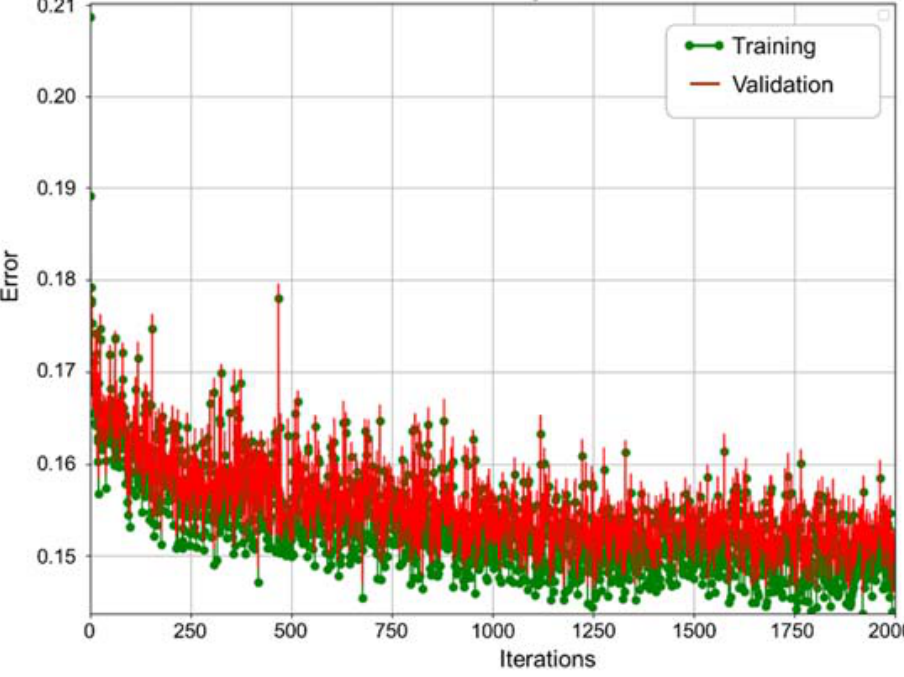
Figure 5. Neural network learning curve.